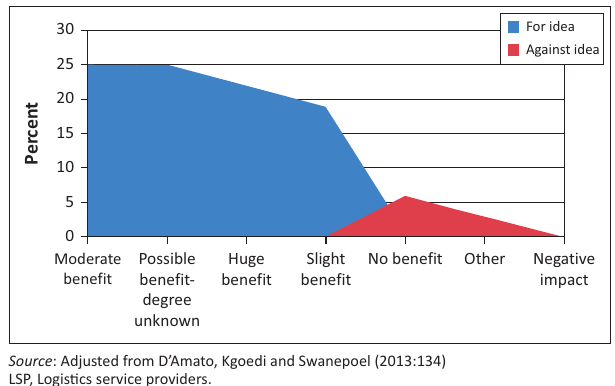
FIGURE 6: Attitude towards LSP providing both planning and execution